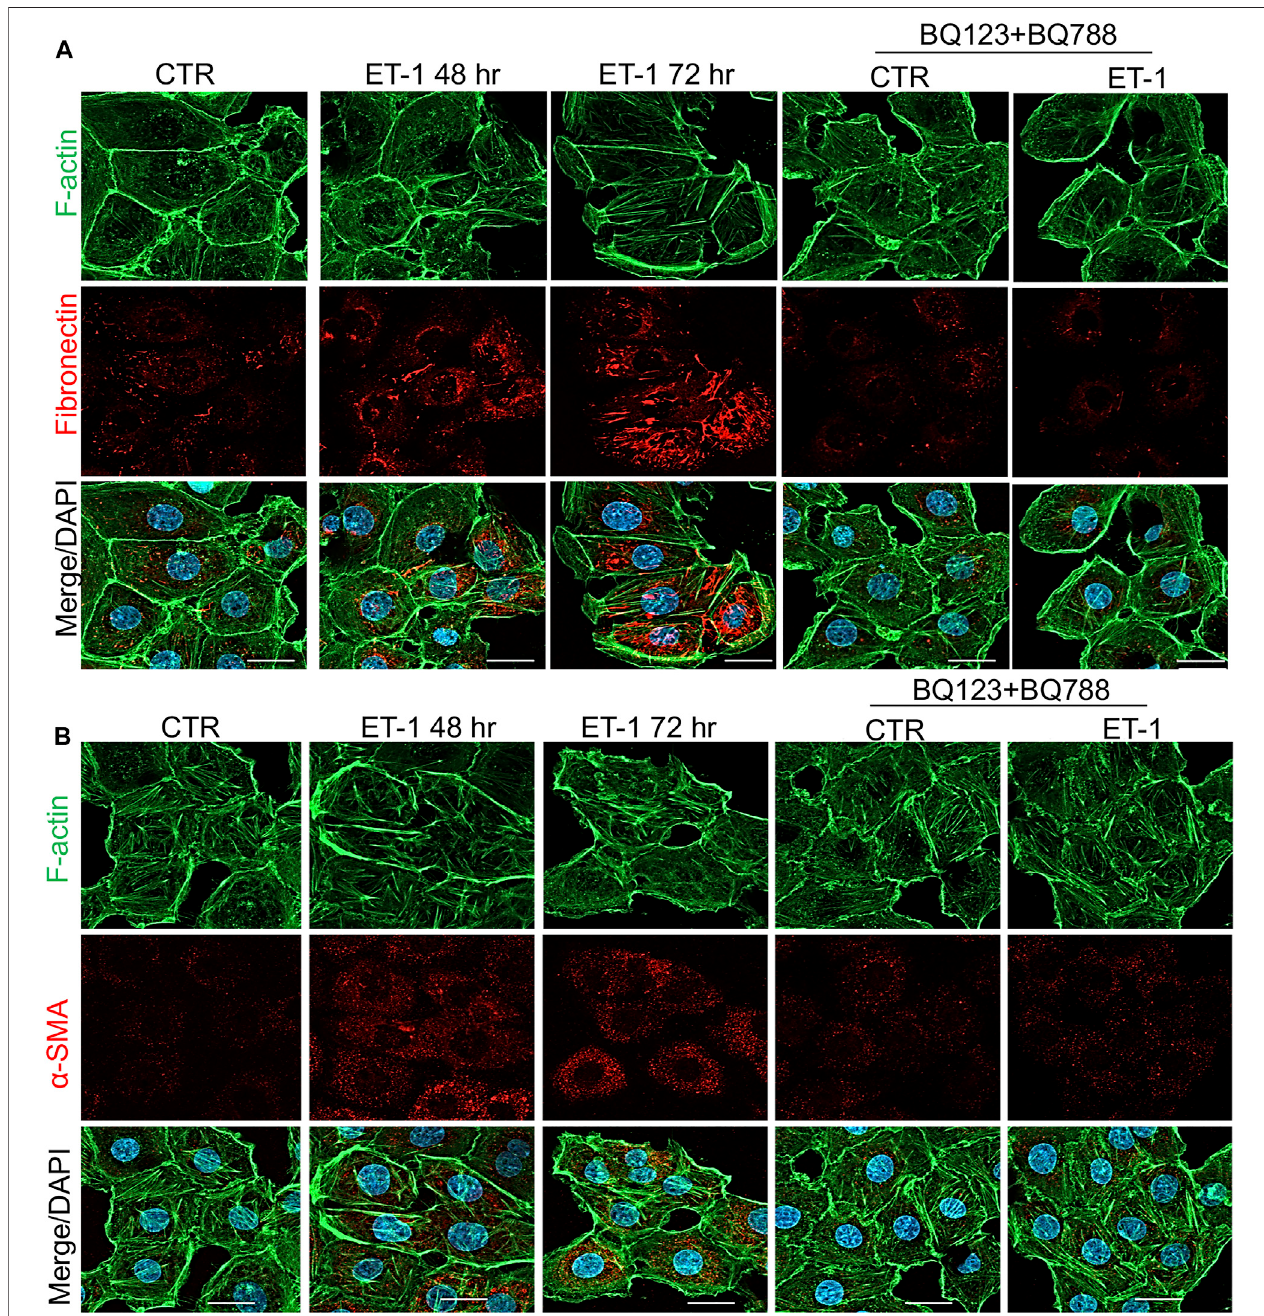
FIGURE 5 | ET-1 upregulates Fibronectin and α -SMA expression through ET A R/ET B R. Representative images of IF analysis of MCs stimulated with ET-1 and/or BQ123+BQ788 for 48 h. (A) Cells are stained for F-actin (green), Fibronectin (red), and DAPI (blue) or (B) for F-Actin (green), α -SMA (red) and DAPI (blue). Bars, 20 µm.